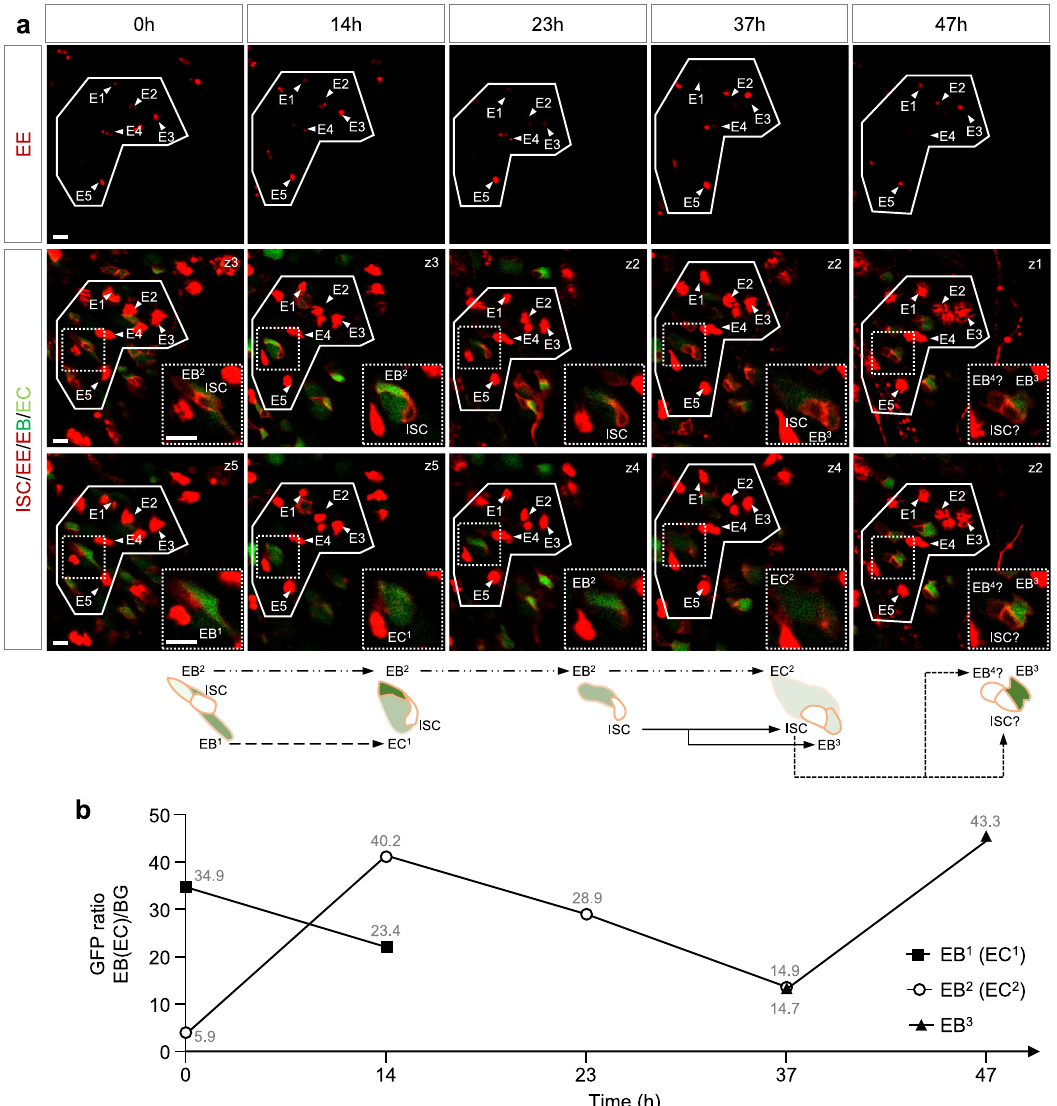
Fig. 6 A “ differentiation-activated ” EB status in the intestine with age-associated hyperplasia. a Representative images of ISC proliferation and EB differentiation in an intestine with age-associated hyperplasia. A pattern of 5 EEs (E1-E5, solid line, fi rst row) was used as a coordinate to re-identify the same intestinal region. An EB-ISC-EB cluster (ISC, EB 1 , and EB 2 , the dashed square is enlarged in the lower right corner) was tracked at 5 time points over 47 h. Two EB-EC transitions (EB 1 to EC 1 , and EB 2 to EC 2 ) were identi fi ed over 37 h. The ISC was divided once to generate an ISC and an EB 3 along with the EC 2 generation. Shortly afterwards, ISC divided again to generate two cells, which probably were one ISC and one EB 4 . Genotype: esg-Gal4 10×UAS- myr:tdTomato, NRE-GFP; pros-QF2 20×QUAS-6×mcherry . Scale bars, 10 μ m. b Quanti fi cation of the GFP ratio in EB 1 (EC 1 ), EB 2 (EC 2 ), and EB 3 . The value of the GFP ratio is indicated at each time